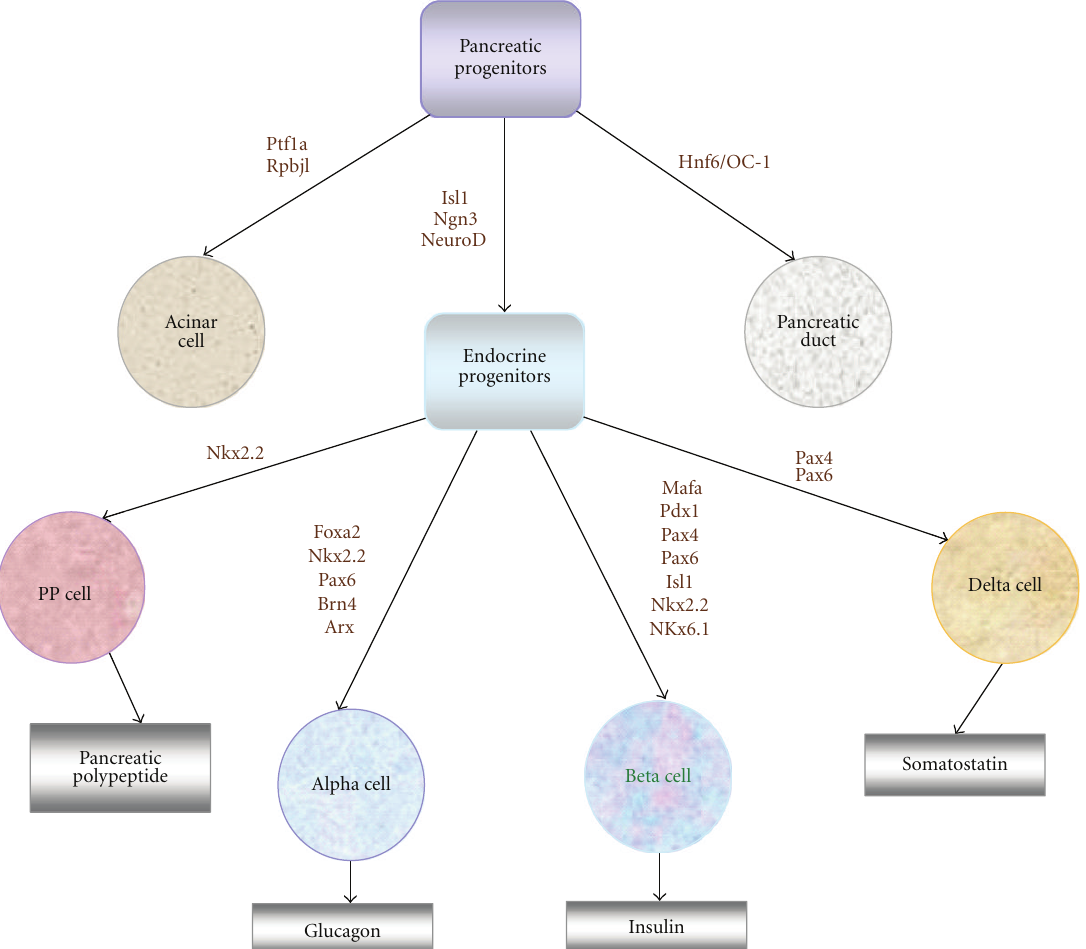
Figure 2: Development of pancreatic beta cells and the associated transcription factors that required for lineage specificity in various steps. Alpha-, beta-, delta-, and pp-cells secrete glucagon, insulin, somatostatin, and pancreatic polypeptide,